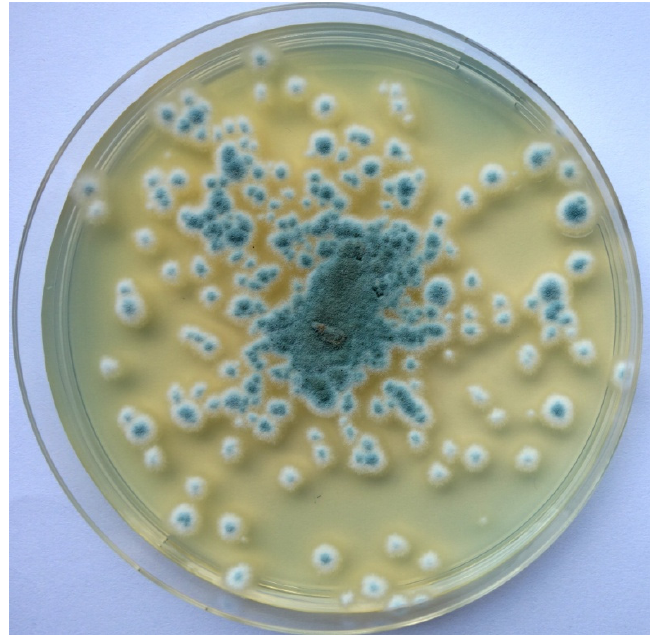
Figure 1. Production of acid by Talaromyces diversus isolated from Golubinka anchialaine cave, strain cultivated on YMA—(Yast Malt Agar) + 20 drops of dibromothymolsulphonephthalein and 10 drops of 10% KOH. Such media were green at the beginning (pH = 7). Paler places indicate an acid production, photo A. Chlebicki.